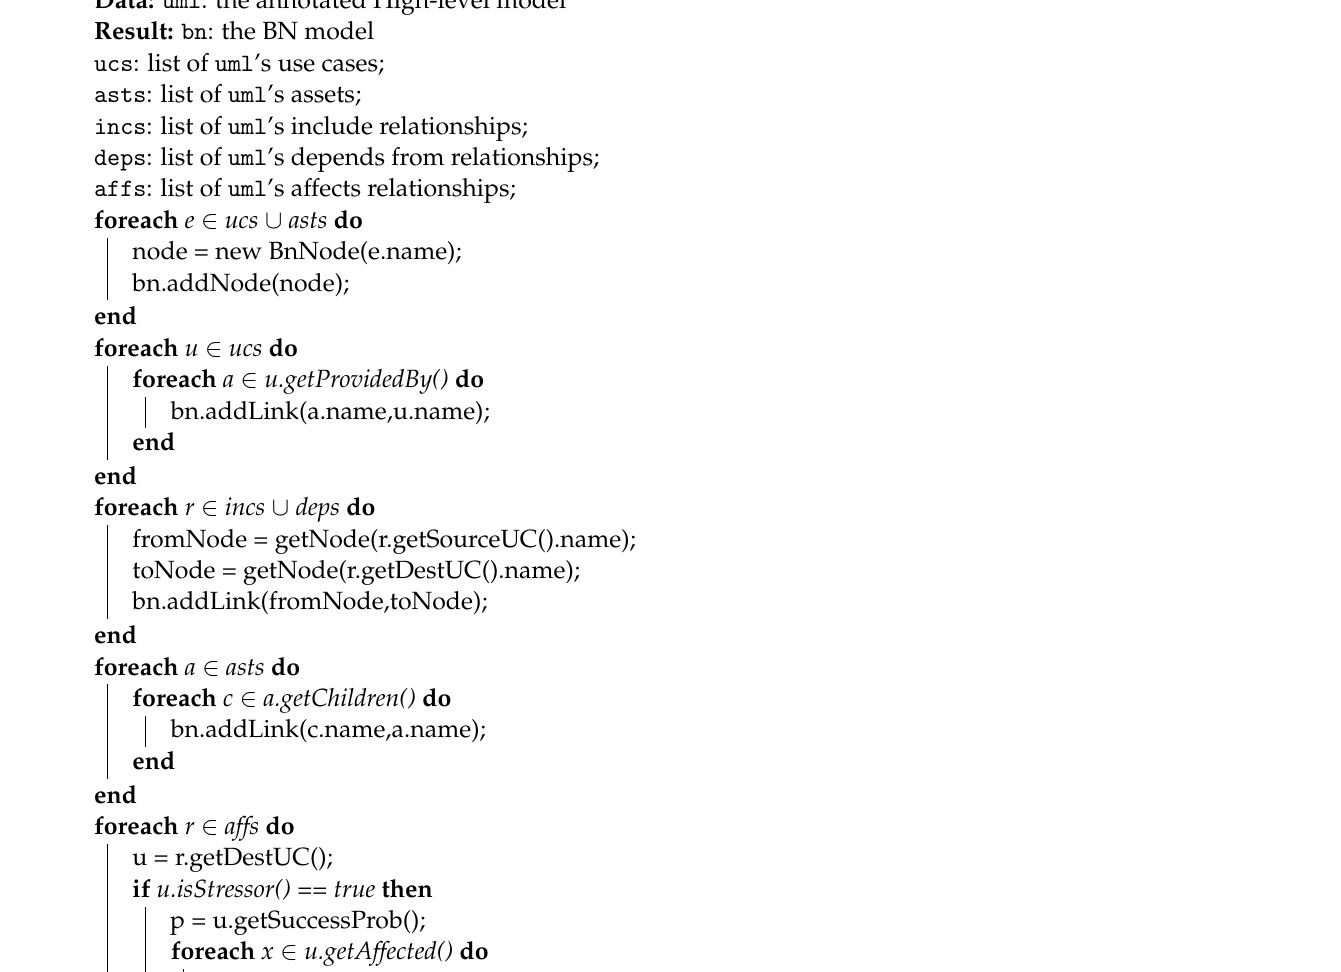
Algorithm 1: Generation of the BN model pseudo-algorithm. Data: uml : the annotated High-level